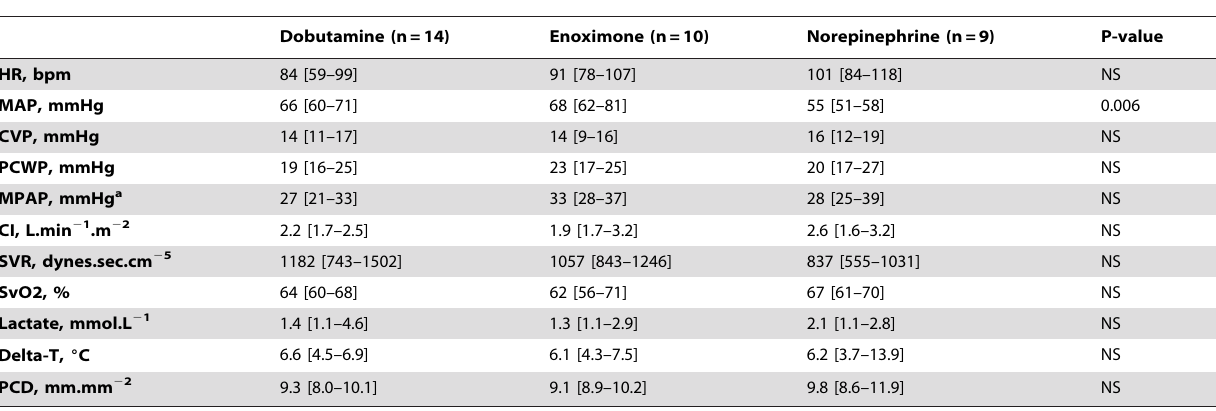
Table 2. Parameters at baseline.